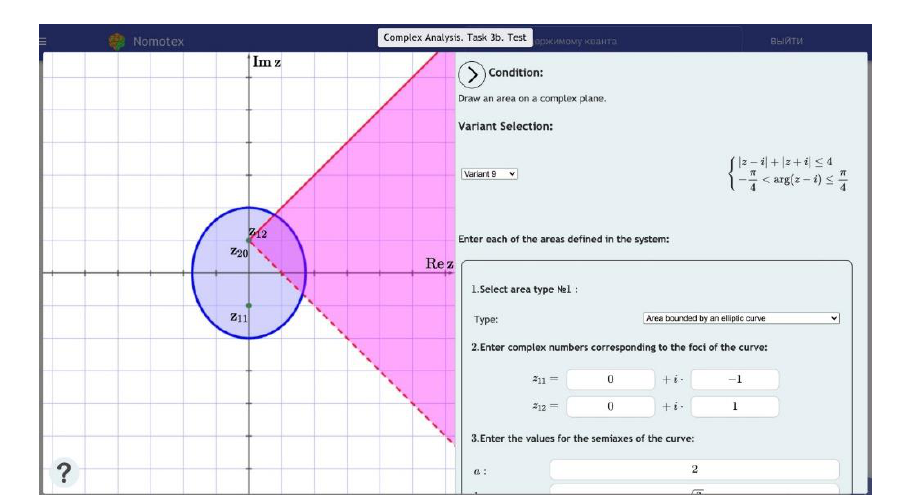
Fig. 5. Typical assignment for the course "Complex Analysis" in DLS NOMOTEX (from examination